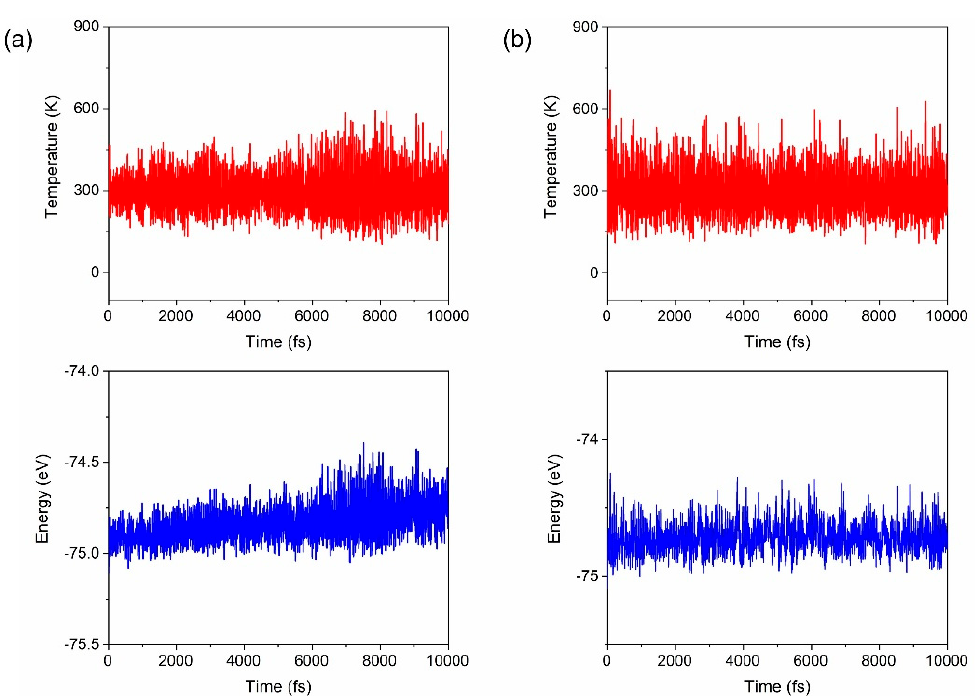
Figure 3. Total energy and temperature fluctuations with respect to time of the AIMD simulation for isomers 1 ( a ) and 2a ( b ) both at 300 K.